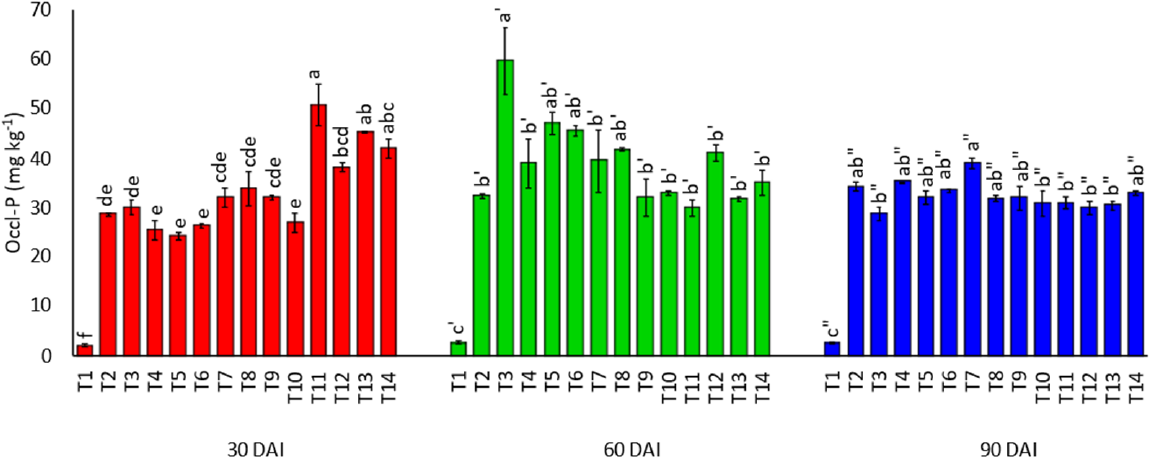
Figure 21. Effects of treatments on occluded phosphorus after thirty, sixty, and ninety days of incubation, where T1: soil alone, T2: Egypt rock phosphate alone, T3: Egypt rock phosphate + 100% charcoal, T4: Egypt rock phosphate + 100% sago bark ash, and T5: Egypt rock phosphate + 100% charcoal + 100% sago bark ash, T6: Egypt rock phosphate + 75% charcoal + 75% sago bark ash, T7: Egypt rock phosphate + 50% charcoal + 75% sago bark ash, T8: Egypt rock phosphate + 25% charcoal + 75% sago bark ash, T9: Egypt rock phosphate + 75% charcoal + 50% sago bark ash, T10: Egypt rock phosphate + 50% charcoal + 50% sago bark ash, T11: Egypt rock phosphate + 25% charcoal + 50% sago bark ash, T12: Egypt rock phosphate + 75% charcoal + 25% sago bark ash, T13: Egypt rock phosphate + 50% charcoal + 25% sago bark ash, and T14: Egypt rock phosphate + 25% charcoal + 25% sago bark ash. Means with different letter(s) within the same incubation period indicate significant differences between treatments according to Tukey’s HSD test at p ≤ 0.05, i.e., a > b > c. Bars represent the mean values ± SE.